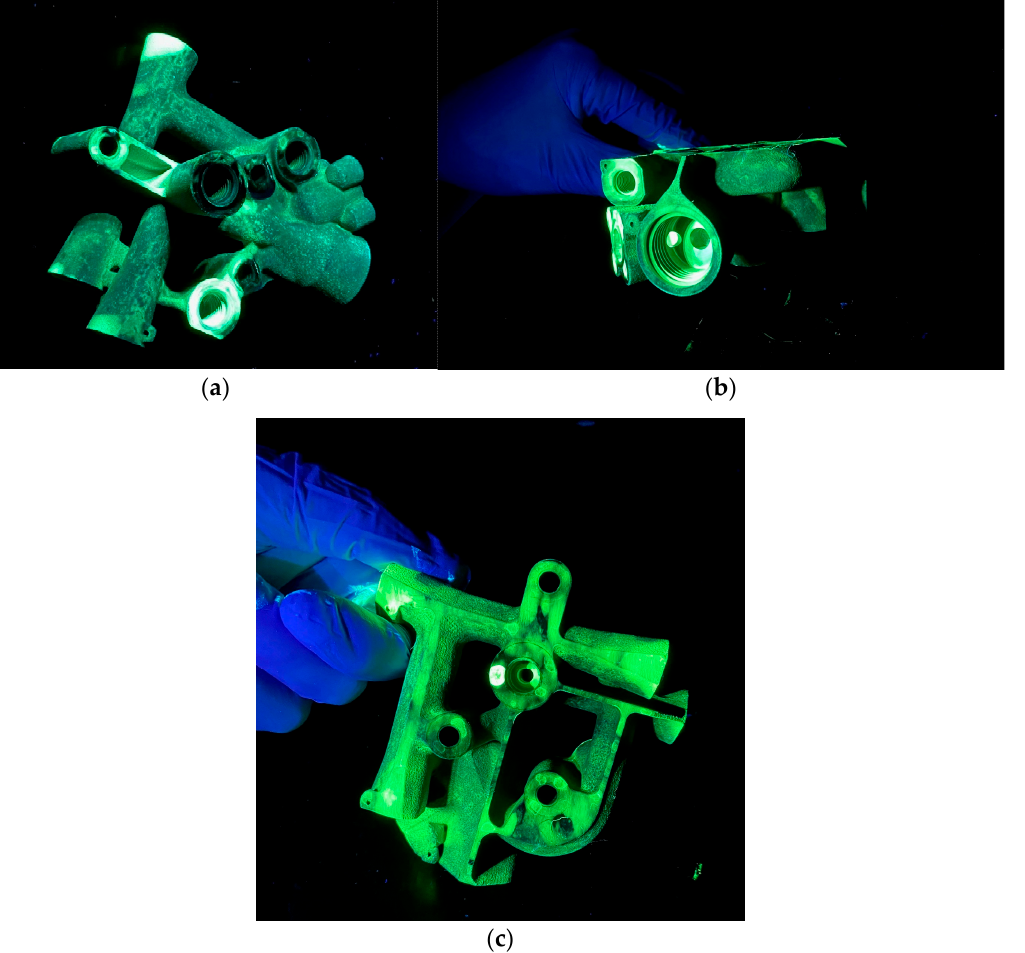
Figure 12. Fluorescent Penetrant Inspection. ( a ) upper side view; ( b ) detail of threaded part; ( c ) bottom side.